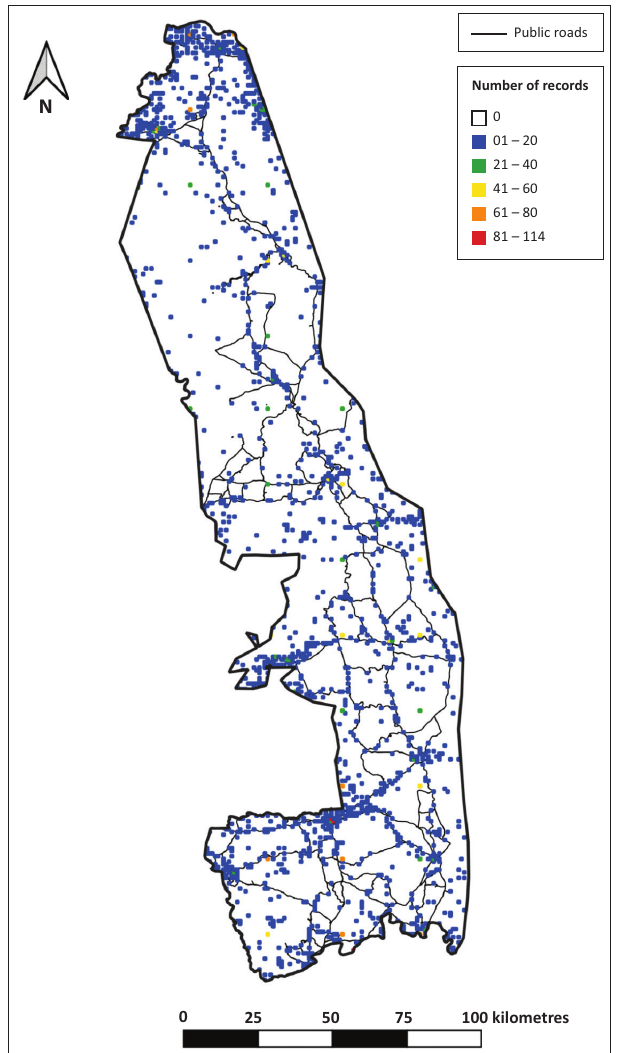
FIGURE 2: Spread of reptile occurrence records across the Kruger National Park at a 1 km × 1 km spatial